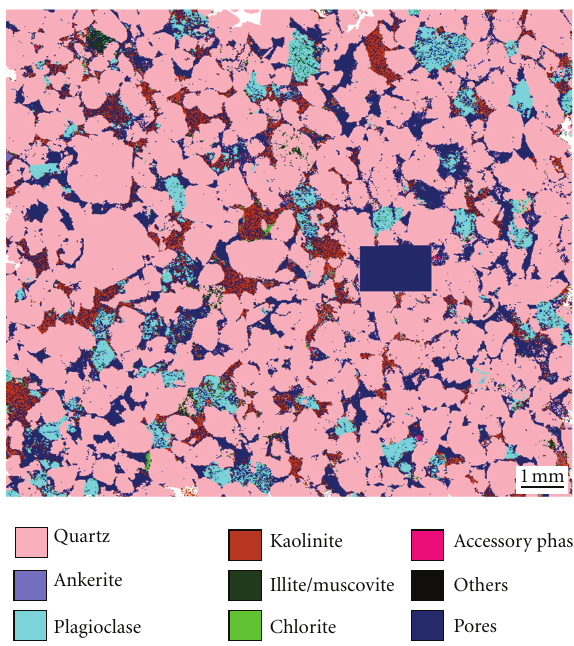
Figure 2: QEMSCAN image from the high-permeability zone. (The solid blue rectangle is a file conversion artifact.)